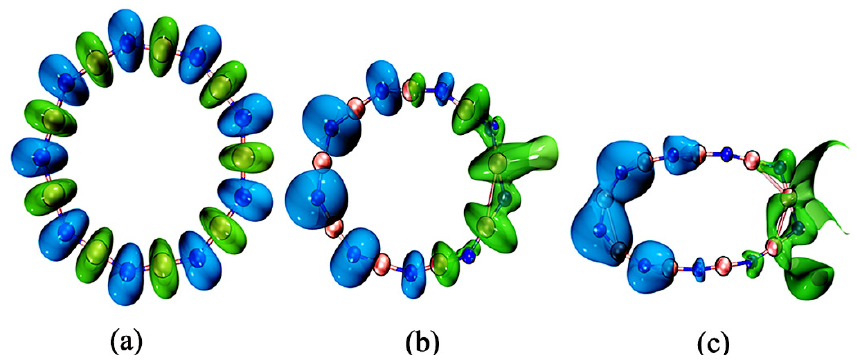
Figure 7. Visualization of dual-descriptor-predicted reactive sites at different EEF strengths; ( a – c ) are dual descriptor isograms; The isovalue is chosen to be 0.03.